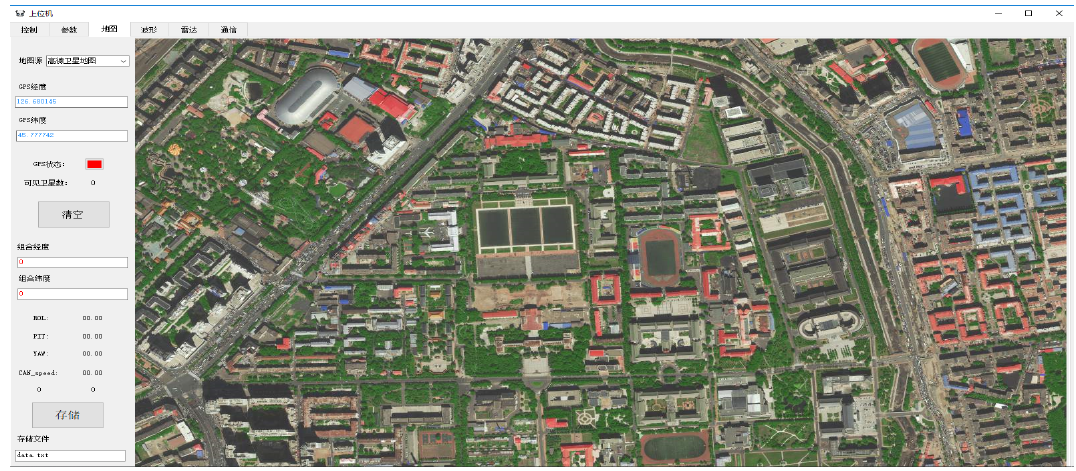
Figure 3. Display system for experiment .